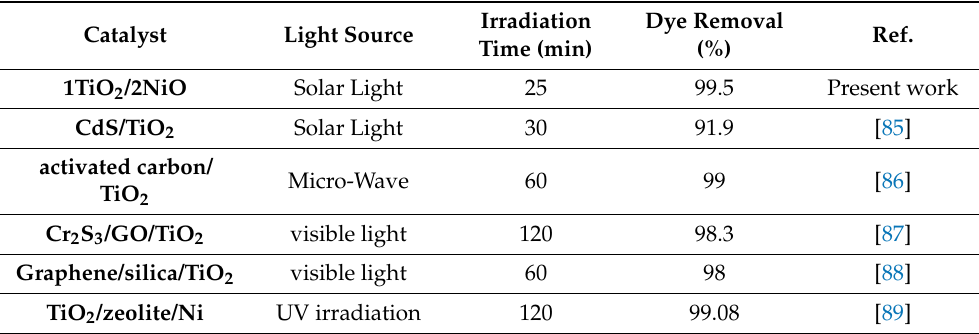
Table 3. Comparison of the efficiency between the present study and previously reported works of photodegradation of MB